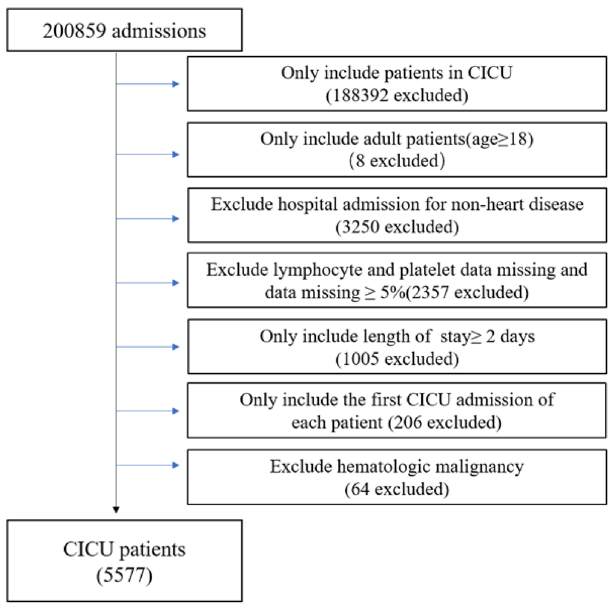
Figure 1. Flow chart of study population. CICU: cardiac intensive care